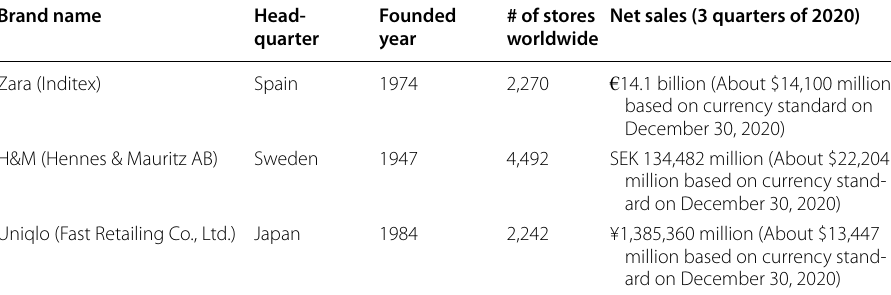
Each group’s standard for financial year is different: Inditex 3 quarters (From February 1, 2020 to October 31, 2020), Hennes & Mauritz AB 3 quarters (From December 1, 2019 to August 31, 2020) Fast Retailing 2–4 quarters (From December 1, 2019 to Number of stores worldwide is on the basis of 2019 year, the latest year that data is available Source: Developed by the authors based on the companies’ websites, annual reports, quarterly consolidated business results, nine‑month report, first‑half of FY2020 fact book, interim nine months 2020 results, and annual accounts report (e.g., Fast Retailing, 2020a, b; H&M Group, 2020a, b; Inditex, 2019, 2020a,